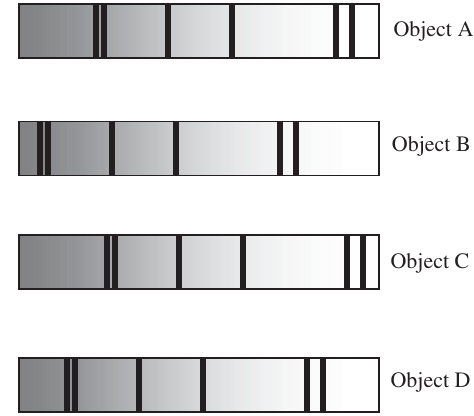
FIG. 2. Items 18 and 19 from the